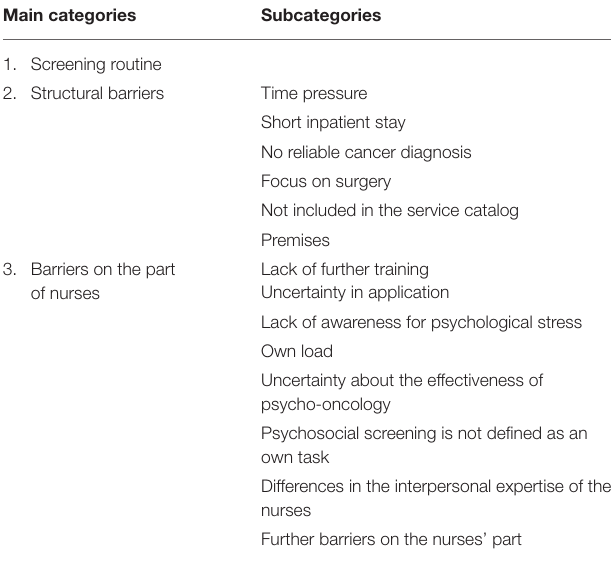
TABLE 3 | Classification of the interview coding into category